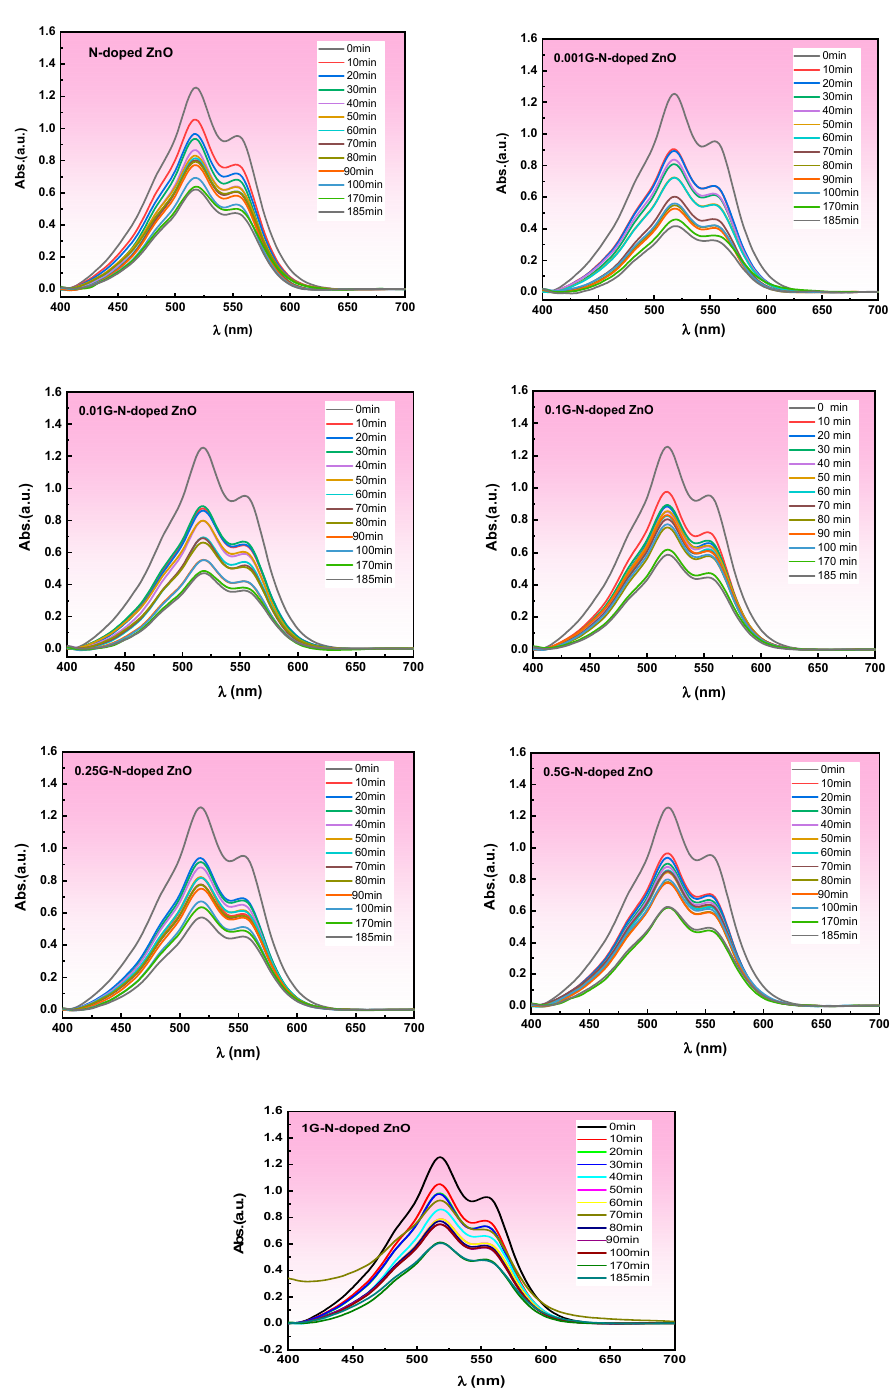
Figure 4. Absorbance spectra of photocatalytic degradation of carmine dye under U.V.C. irradiation in situ with N-doped ZnO and G/N-doped ZnO with different concentrations of graphene.